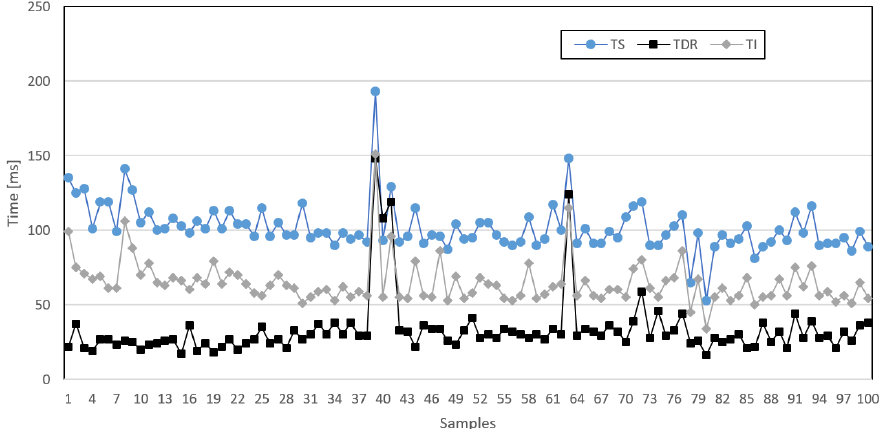
Figure 8. Comparison between the time required to consume the service in the proposed scenario ( T S ), which includes the use of interface ( T I ), and the time required to consume the service making a direct request ( T D R ) using a CoAP interface without any interoperability